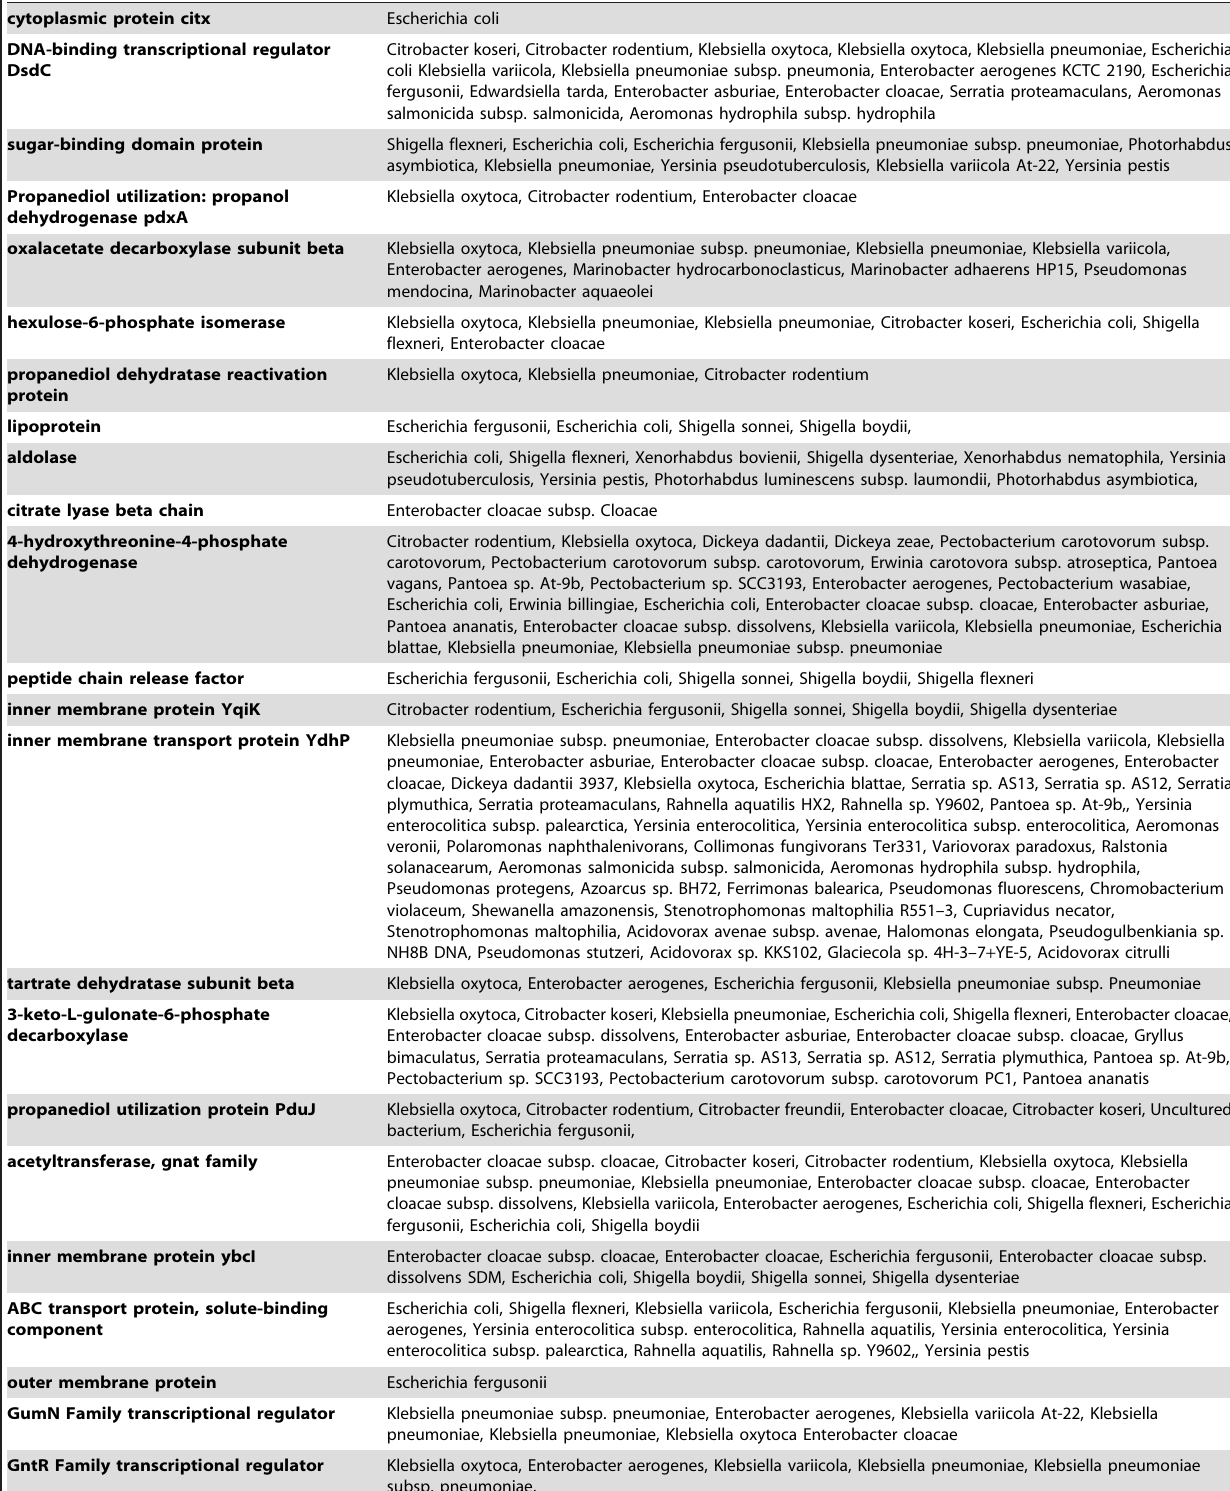
Putative protein product